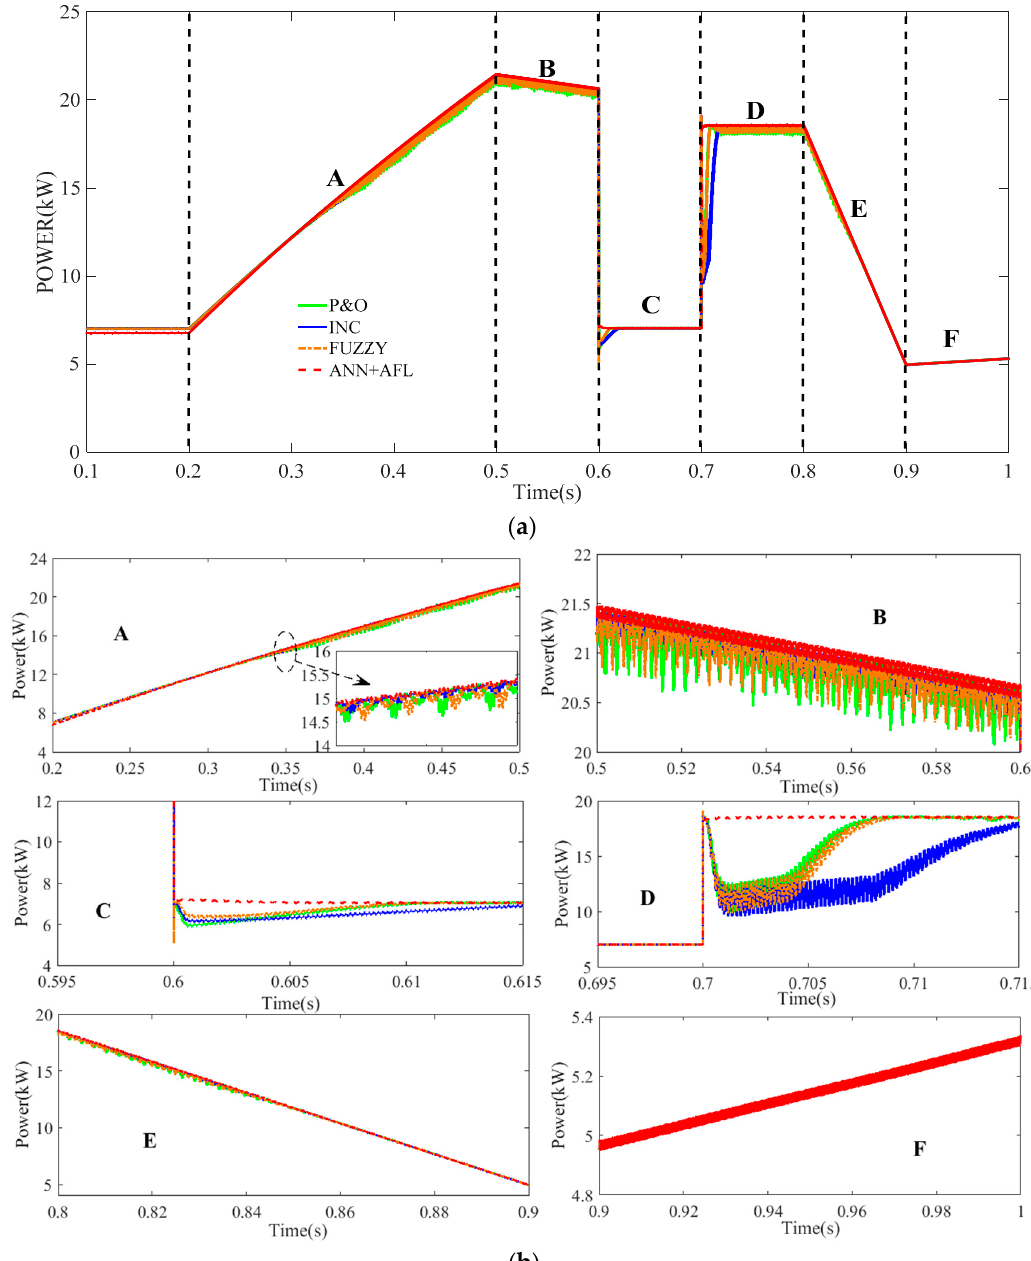
Figure 13. Output powers of PV system with perturb-and-observe (P&O), incremental conductance (INC), fuzzy, and ANN + AFL methods: ( a ) Output power (overall); ( b ) Output power (detailed).